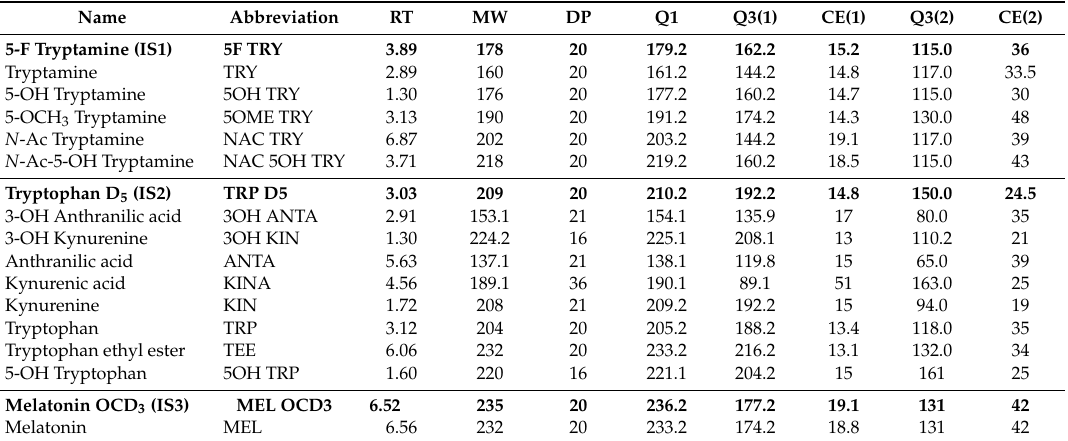
Table 1. Conditions for LC-MS / MS analysis of indole